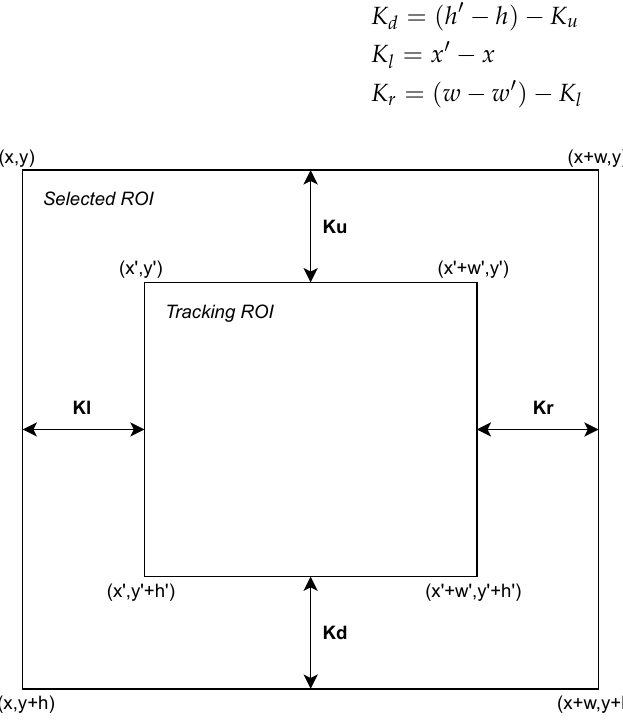
Figure 6. Representation of K